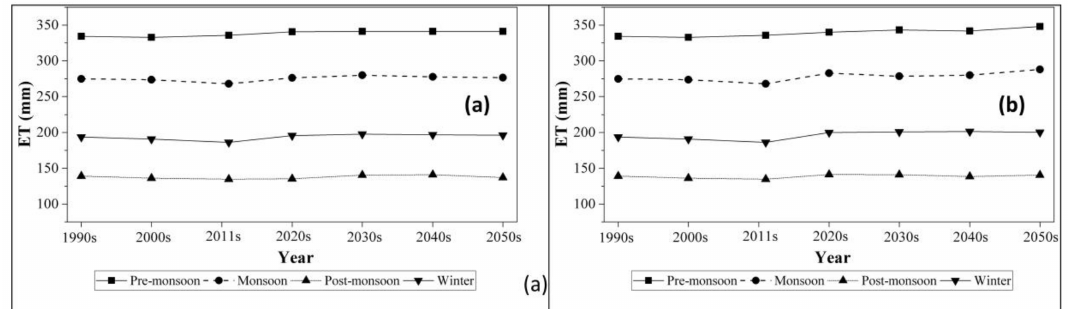
Figure 11. Climate change impact on ET ( a ) RCP4.5; ( b ) RCP8.5.